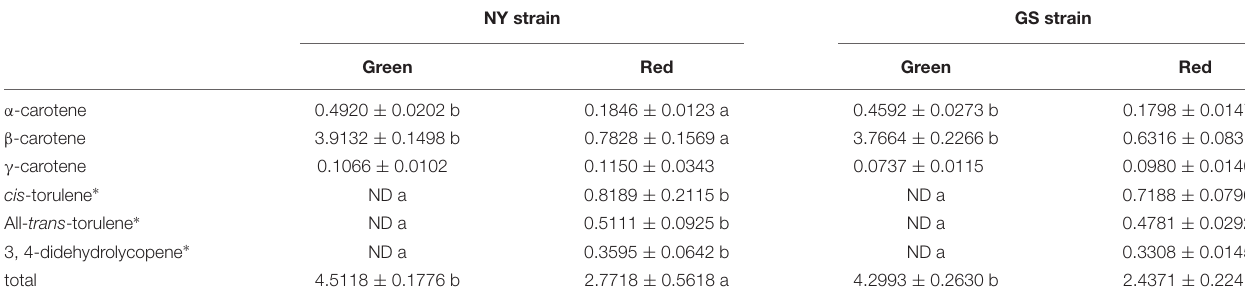
TABLE 1 | Carotenoid content of green and red morphs from NY and GS strains of Acyrthosiphon pisum .